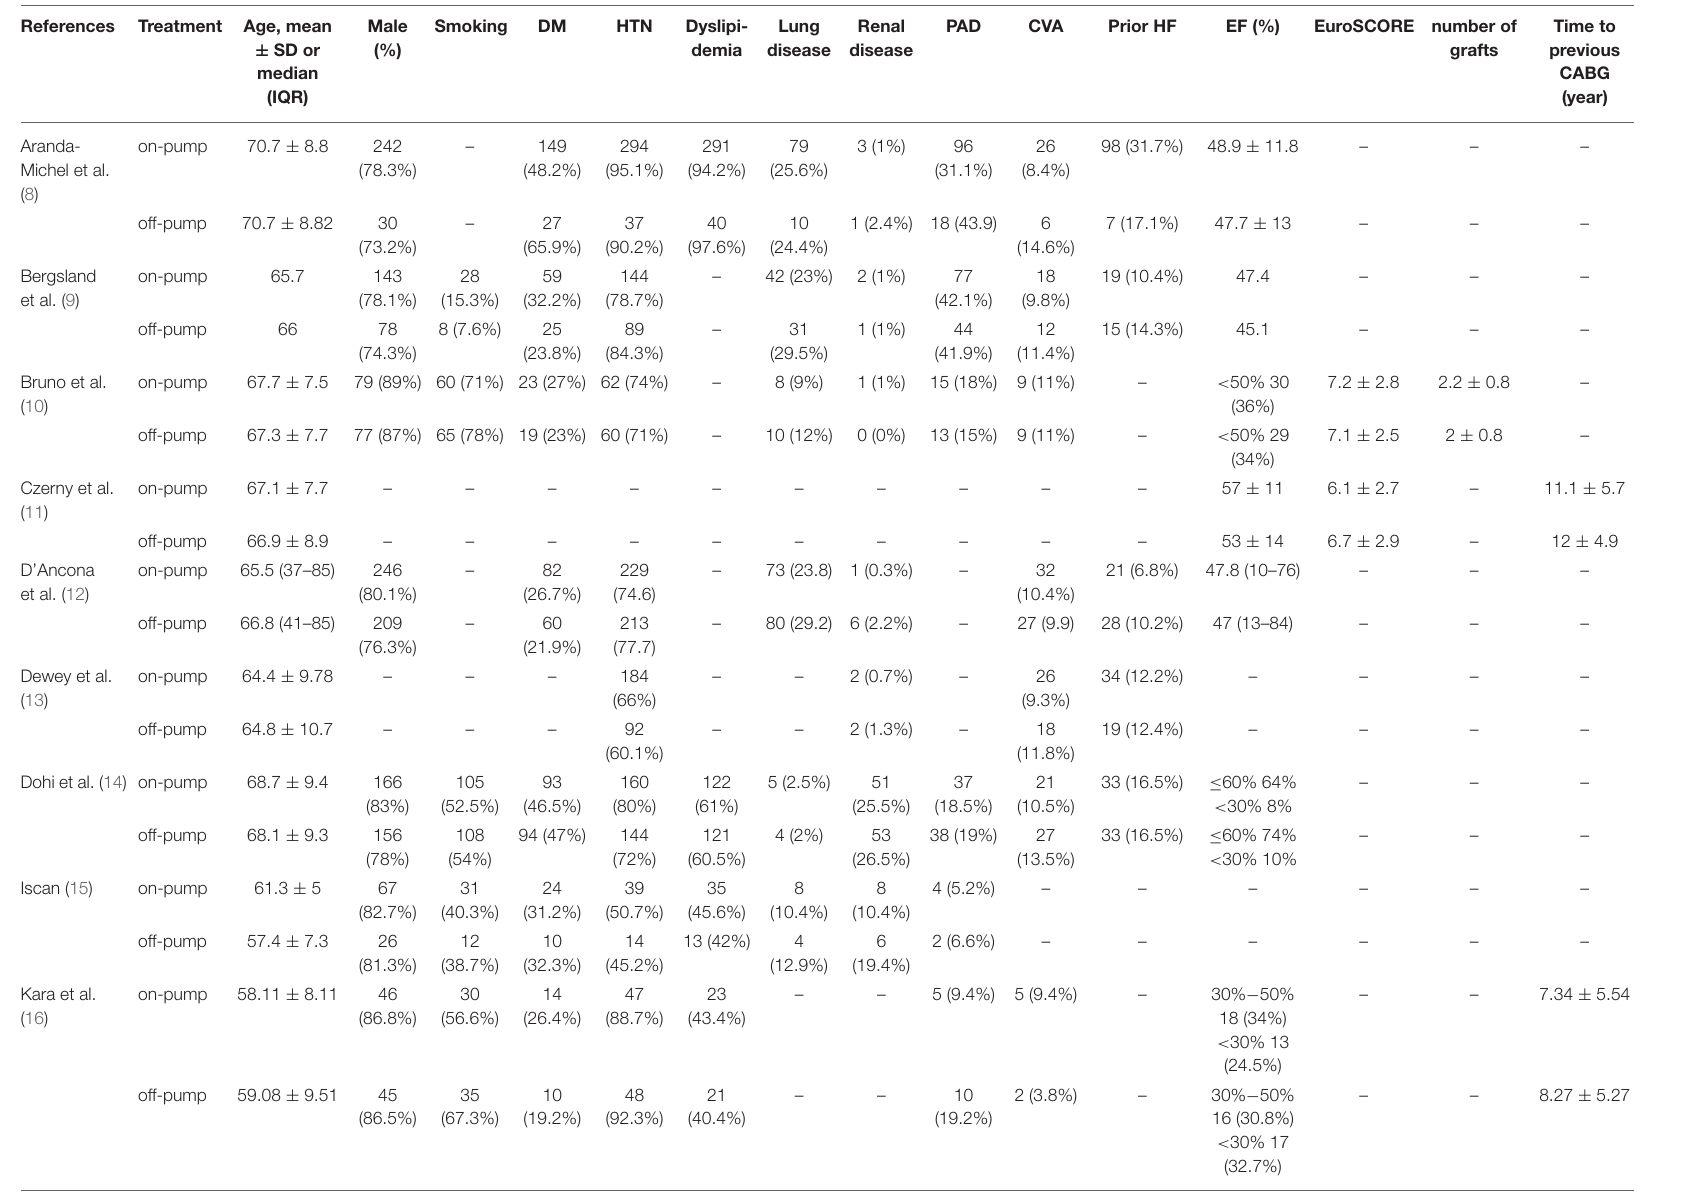
TABLE 3 | Detailed demographic characteristics of individuals in the included